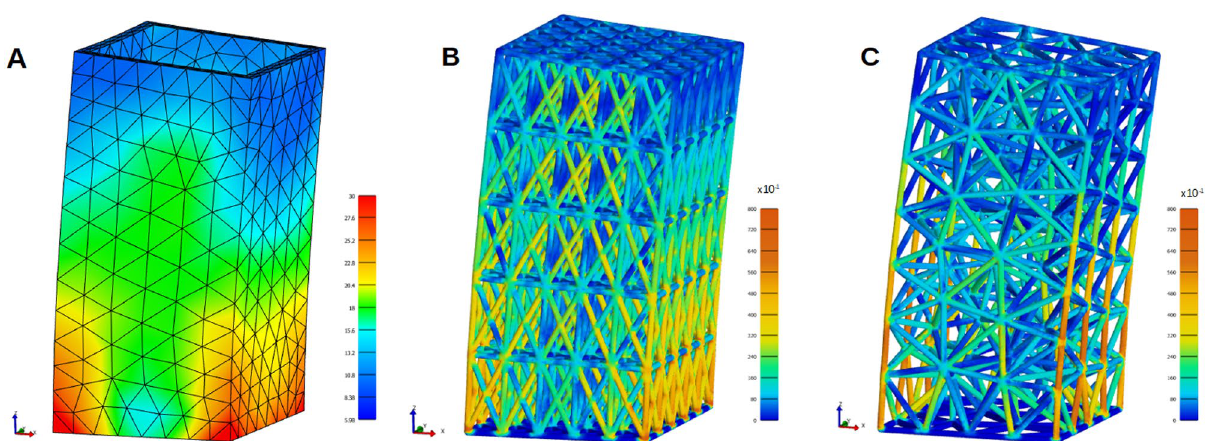
Figure 16. Bending stress (von Mises) and deformation of ( A ) the original solid/shell, ( B ) a high density lattice, and ( C ) a mid-density HGon (8 × 5). Note the high stress concentrations at the lower lattice ( B ) base joints which do not appear in the HGon meta-structure. Deformations are magnified 5× for